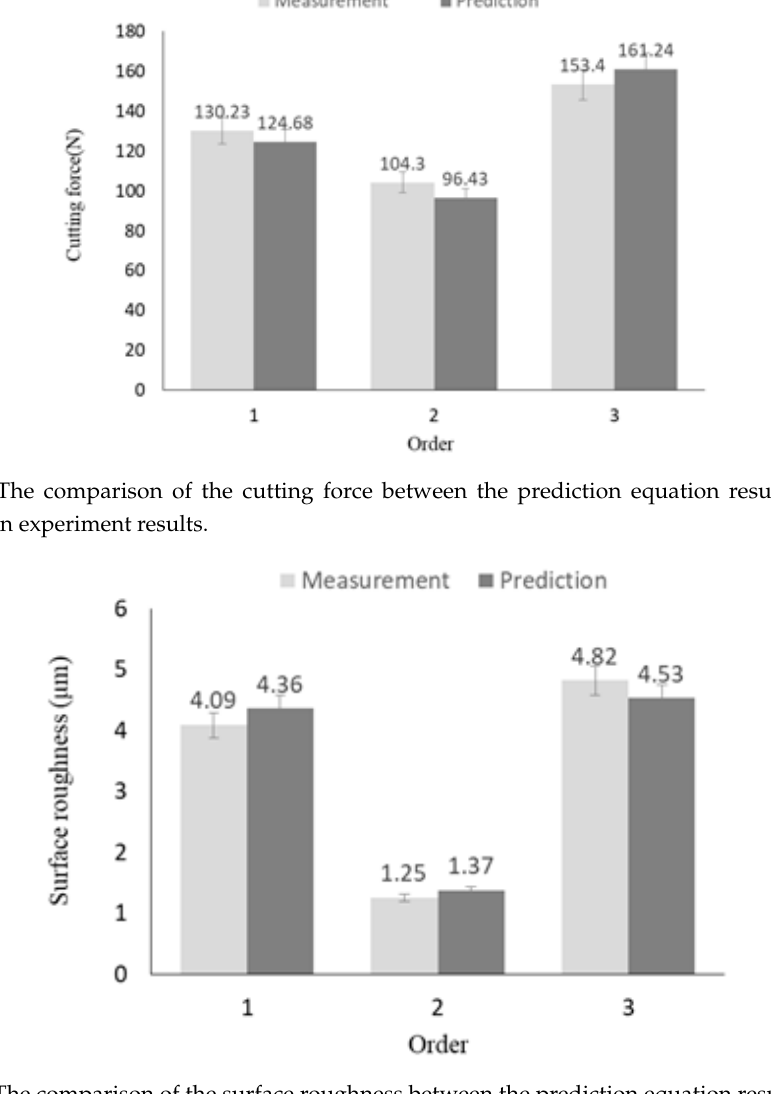
Figure 10. The comparison of the surface roughness between the prediction equation results and the confirmation experiment results.